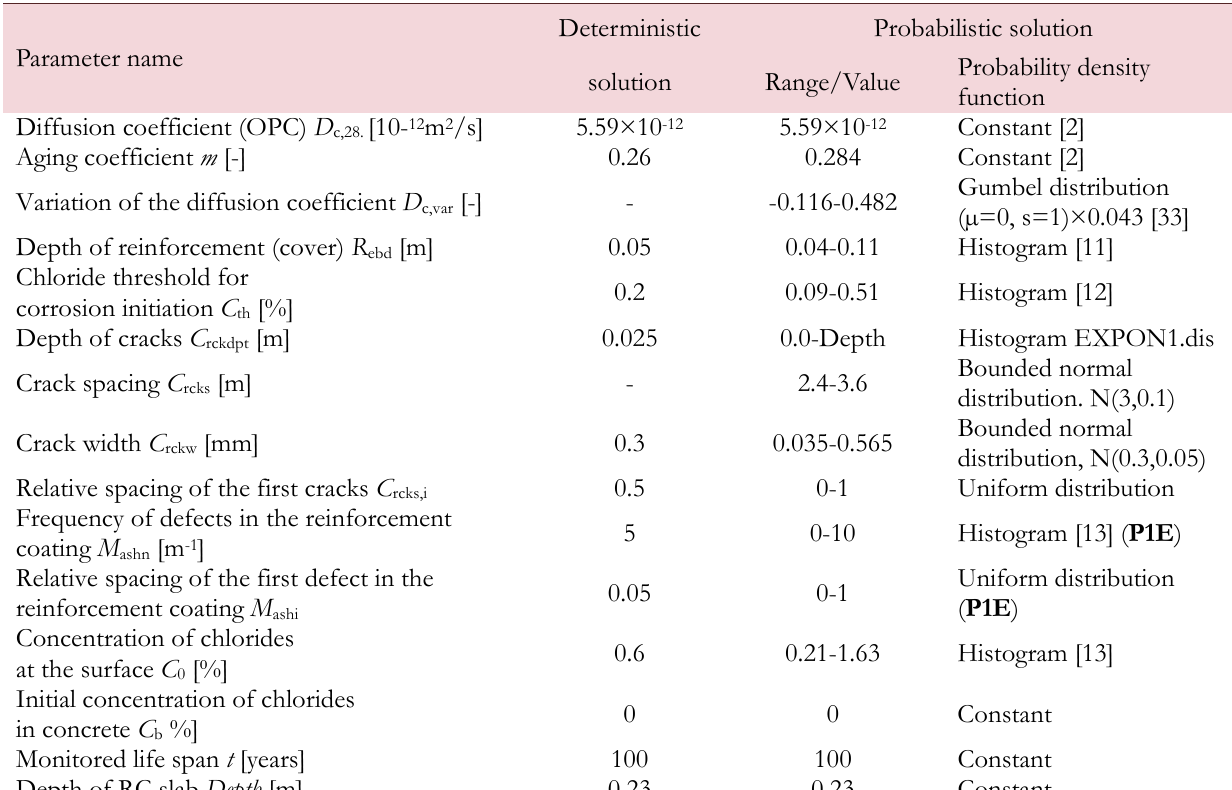
Table 1: The random variables and deterministic input parameters for ordinary concrete and a directly exposed reinforced concrete bridge deck with a crack (P1B - unprotected steel reinforcement, P1E - steel reinforcement protected by an epoxide coating). The parameters that belong exclusively to P1E are marked in the